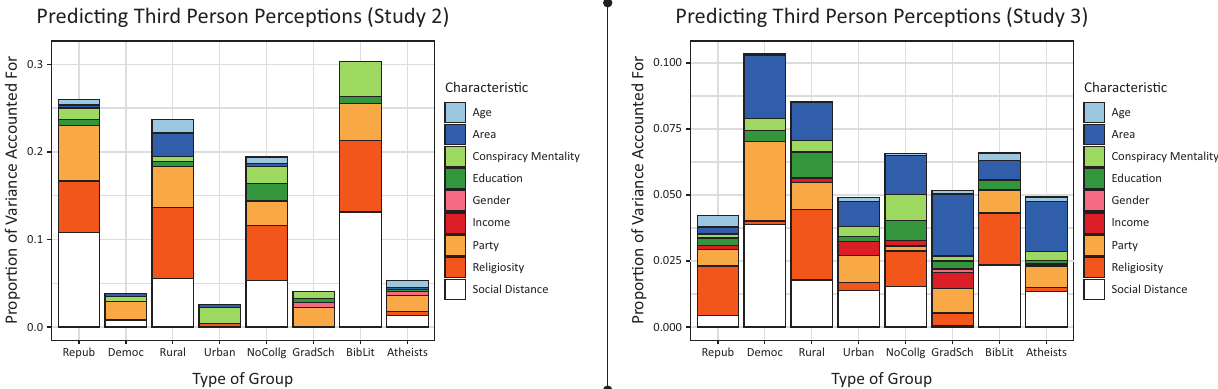
Figure 3. Relative importance of the predictors for studies 2 and 3. Please note the vertical axes differ for the two figures. Media and Communication, 2020, Volume 8, Issue 2, Pages